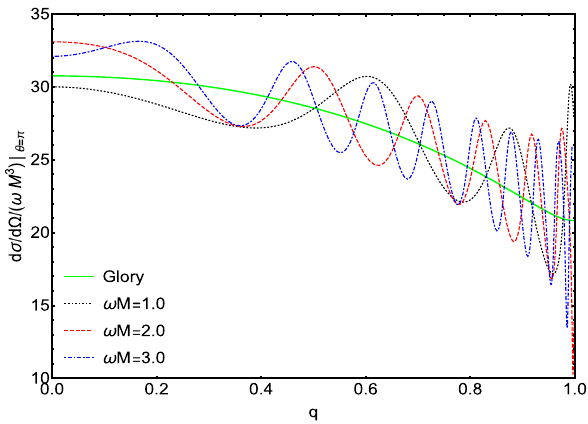
Fig. 8 Amplitudes of the backscattered waves ( θ = 180 ◦ ) as functions of q for different values of ω M . The solid green line is given by the glory approximation